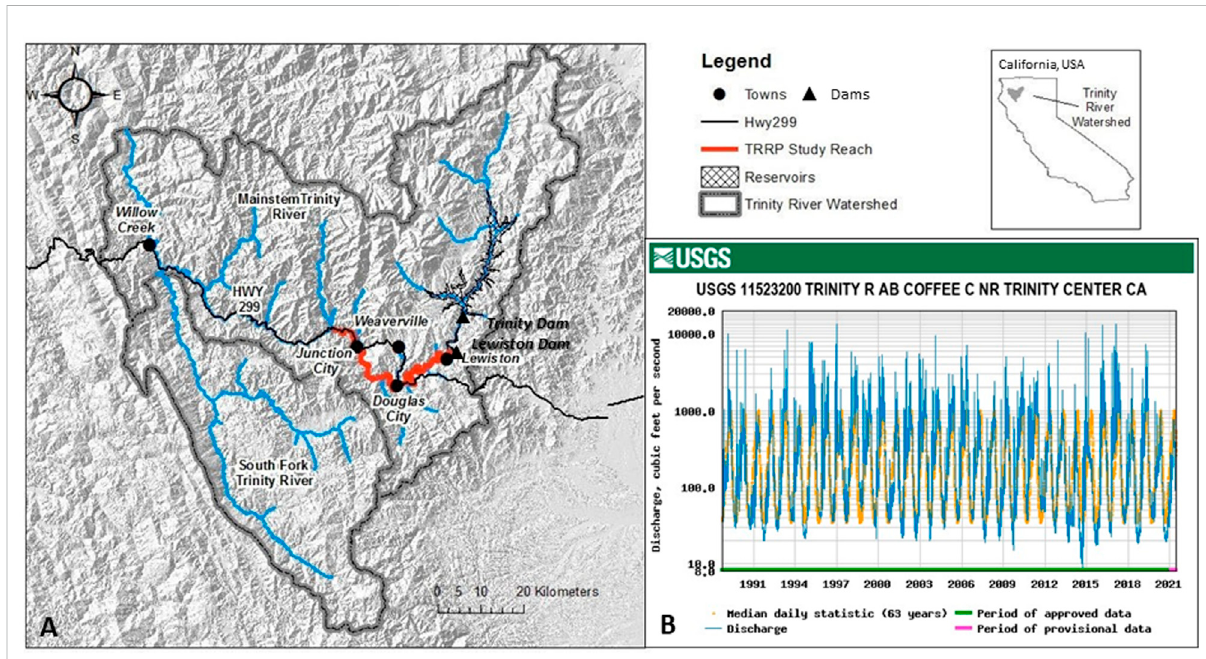
FIGURE 5 Geography and hydrology of the Trinity River. (A) Watershed location in California, United States (Lat: 40.7249 ° N; Long: 122.7961 ° W). (B) Unimpaired hydrographupstreamofLewistonandTrinityDams.MapfromUSGS; fl owdatafromUSGSgage11523200(https://nwis.waterdata.usgs. gov/ca/nwis/); “ Median daily statistic ” is the average daily fl ow over the period of record (1953 –